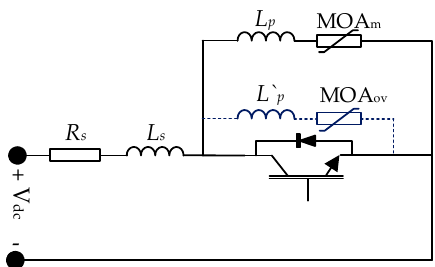
Figure 8. A scheme for protection of PE switches against overvoltage.